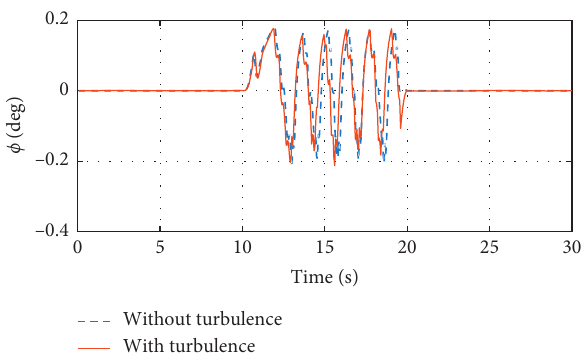
Figure 11: The difference of rolling angle with the